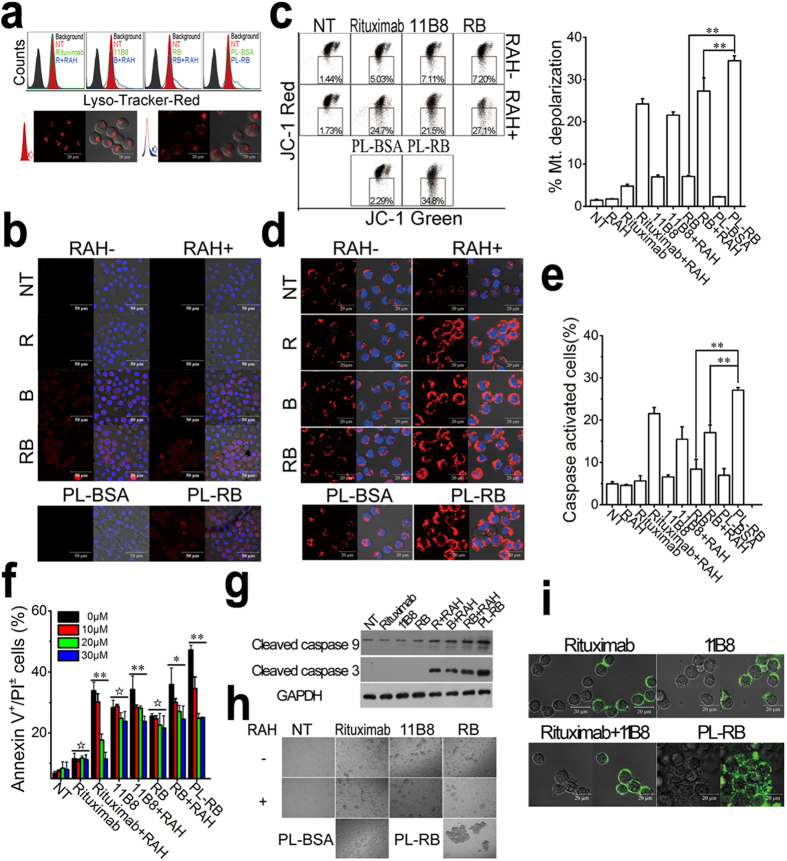
In vitro potent anti-lymphoma activity by PL-RB.(a-b) Lysosome related: (a) The volume of the lysosomal compartment was measured by FCM and CLSM after labeling with LysoTracker-red probe. (b) Confocal microscopy of cathepsin B staining (red). DNA was counterstained with DAPI (blue). (c-d) Caspase related: (c) Detection of mitochondrial membrane potential (MMP) indicated by decrease of fluorescence intensity of FL-2 (JC-1 Red) (gate of the left panel). The percentage of cells with mitochondrial depolarization was shown in the right panel. Data are expressed as means ± SD (n = 3). (d) Effect of anti-CD20 mAbs and PL-RBs on Cyto chrome c release by CLSM. Cells were fixed and labeled for Cytochrome c (red) and DNA (blue). (e) Caspase activation in PL-RB induced apoptosis indicated by FLICA reagent in FCM. The percentage of caspase activativation was calculated as mean ± SD (n = 3). (f) Apoptosis can be partly inhibited by a caspase inhibitor (Z-VAD-FMK). Raji cells were treated for 30 minutes with 0, 10, 20, 30 μM Z-VAD-FMK before addition of mAbs and PL-RBs. Data are expressed as mean ± SD (n = 3) (**p < 0.01, *p < 0.05, ☆p > 0.05). (g) Western Blotting analysis of cleaved caspase 3/9 of Raji cells treated with PL-RB and parental mAbs. (h-i) Effect of PL-RB and parental mAbs on the crosslinking of Raji cells indicated by light microscopy (h) or confocal microscope following staining with Alexa Fluor-488 goat anti-human secondary antibodies (I).